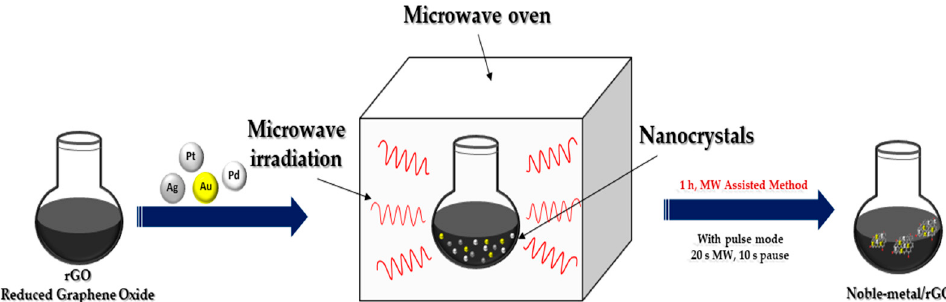
Figure 4. Microwave irradiation synthesis of noble metal nanocomposites.